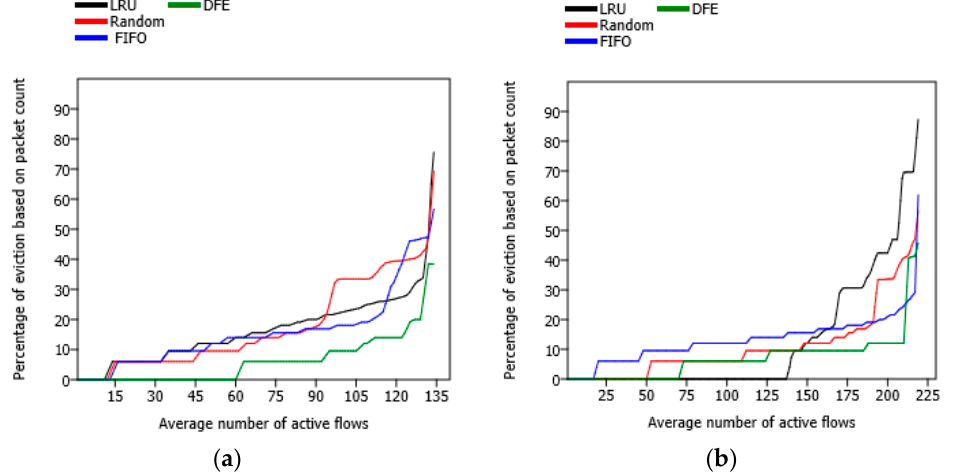
Figure 9. Flow eviction result with fixed and di ff erent flow table size. ( a ) Percentage of eviction with respect to number of active flows. ( b ) Percentage of eviction with increase in tra ffi c flows, and flowtable